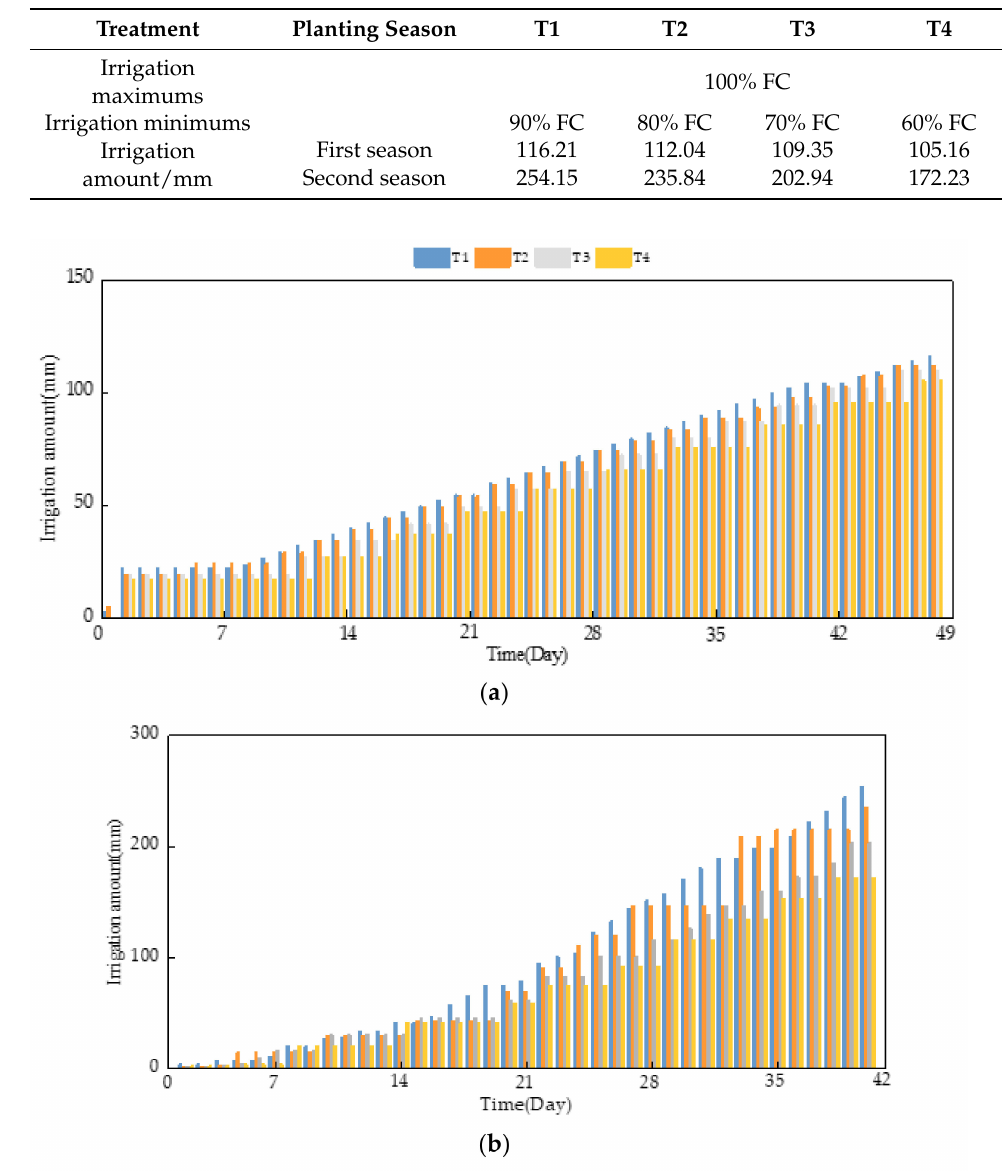
Figure 1. Irrigation amount and irrigation time ( a ) irrigation amount and irrigation time for planting lettuce in the first season, ( b ) irrigation amount and irrigation time for planting lettuce in the second